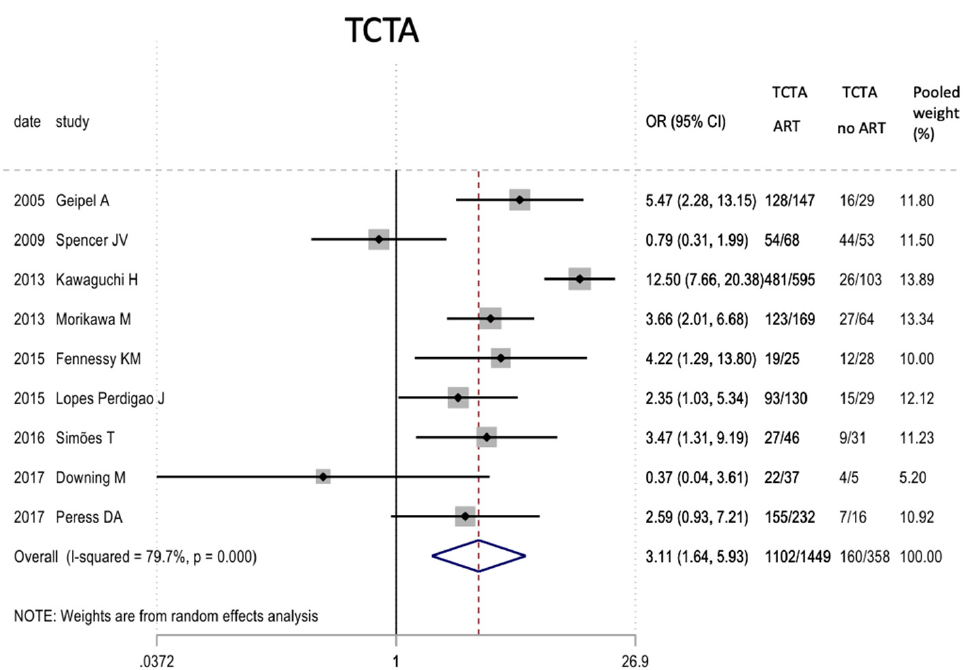
Figure 4. Results of the meta-analysis on the effect of chorionicity (TCTA vs no TCTA) on prematurity in newborns (under 37 weeks). Premat: prematurity, TCTA: tricorial-triamniotic, non- TCTA: non-tricorial-triamniotic. OR = odds ratio, CI = confidence interval.